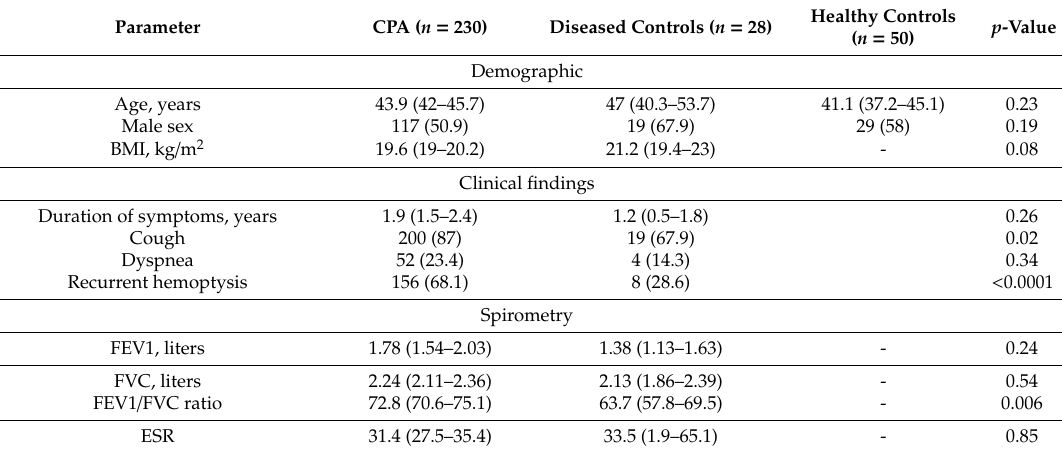
Table 1. Demographics and clinical profile of the study